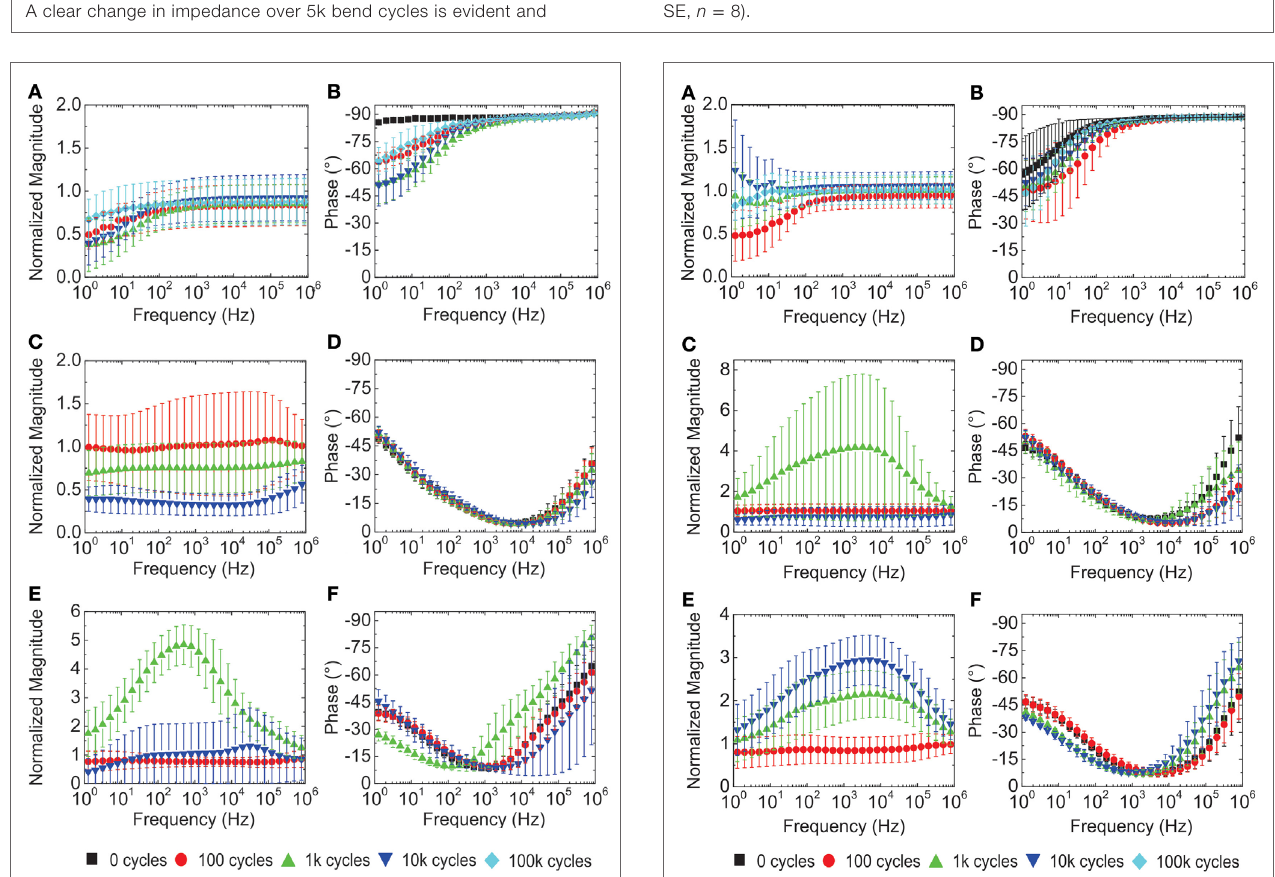
FigUre 11 | representative transverse (a–c) and lateral (D–F) impedance from a PMP device released from a wafer that peel testing revealed had uneven adhesion of the top layer of Parylene . A clear change in impedance over 5k bend cycles is evident and